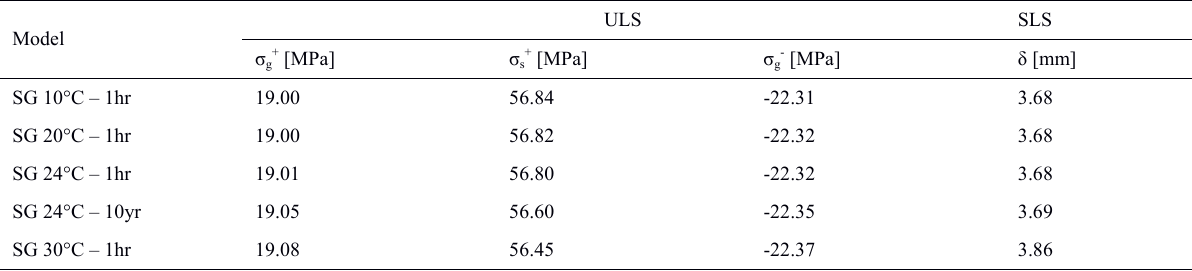
Table 4: Maximum values of stresses and vertical